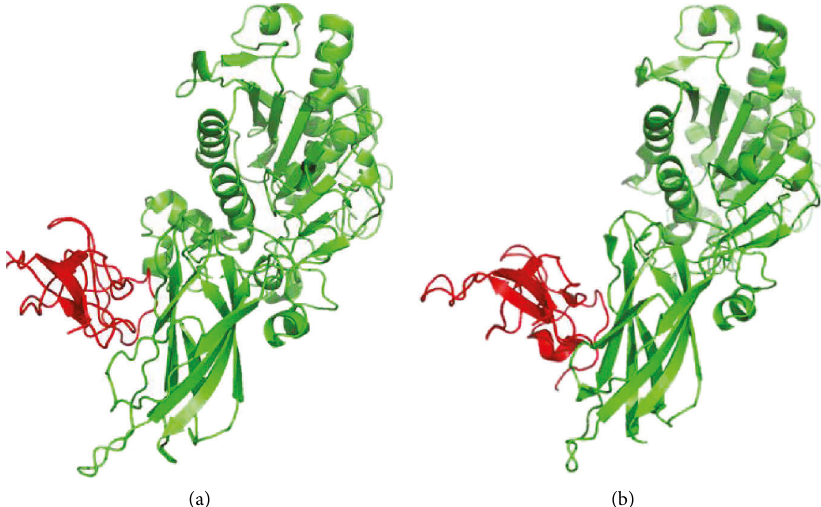
Figure 6: Three-dimensional protein structures of two pancreatic lipases from different origins. (a) Porcine pancreatic lipase (green) with colipase (red) (PDB ID, 1ETH). (b) Human pancreatic lipase (green) with colipase (red) (PDB ID, 1N8S). These lipases have 86.35% identity in amino acid sequence (some mutations included), which means that they are almost the same protein in structure.